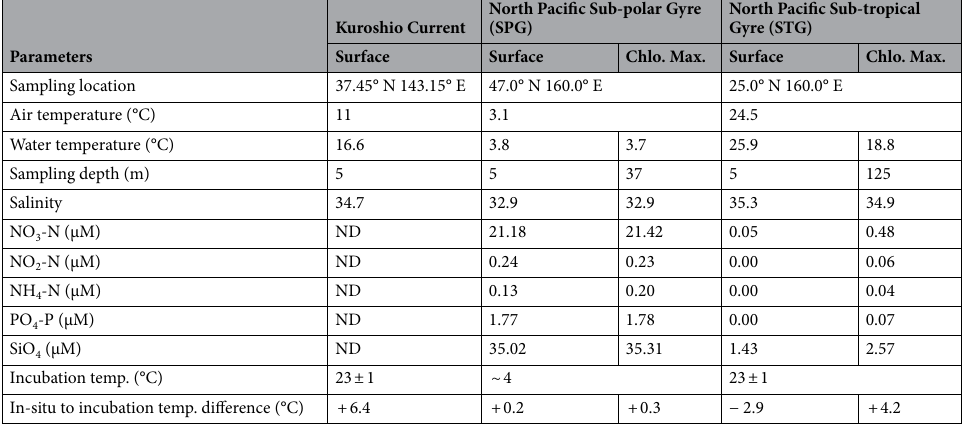
Time sampled after the initiation of the